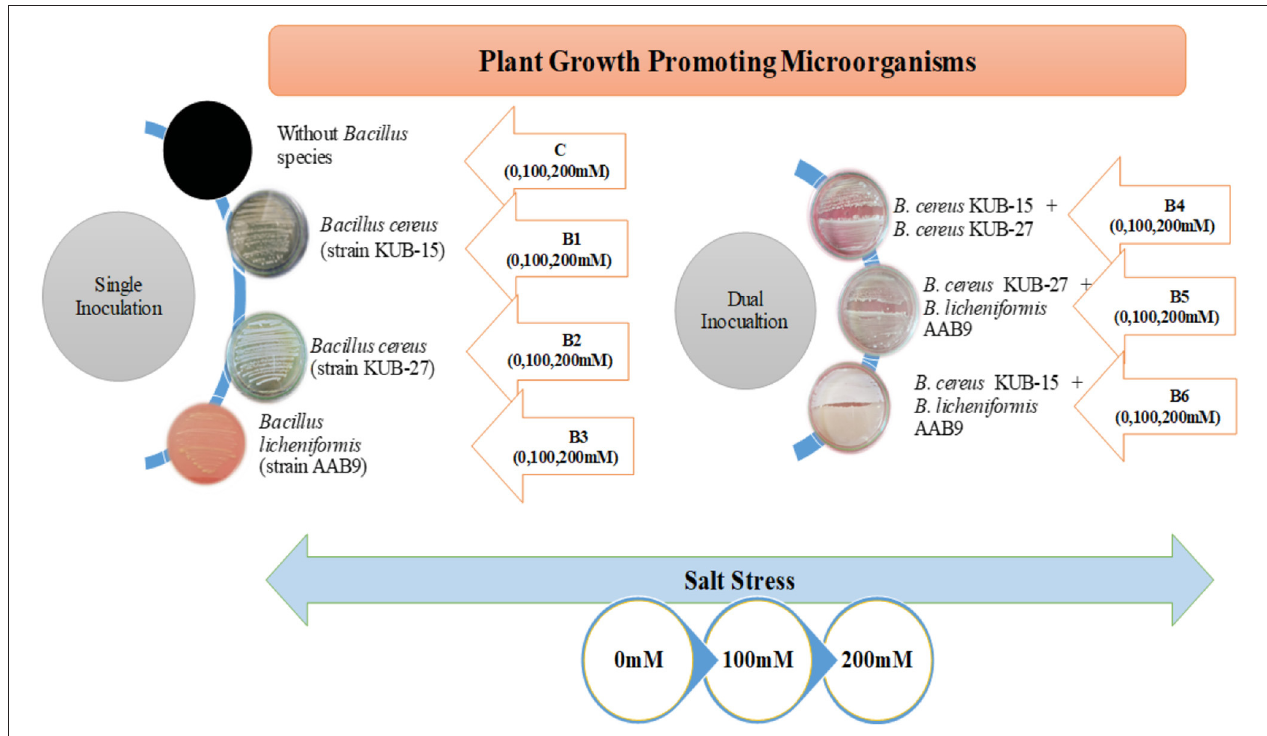
FIGURE 1 | Schematic representation of bacterial treatments and stress application in